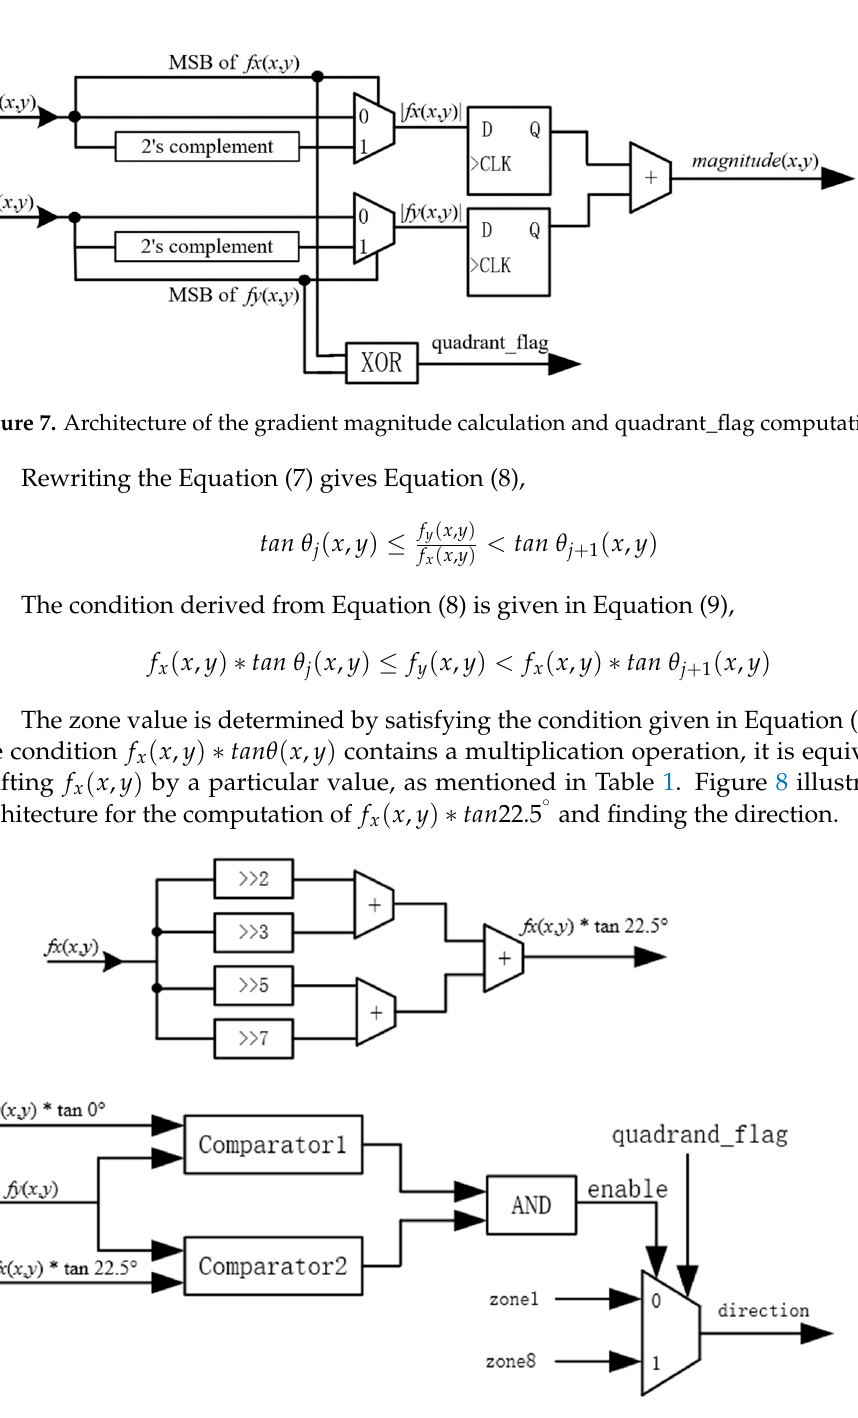
Figure 7. Architecture of the gradient magnitude calculation and quadrant_flag computation.